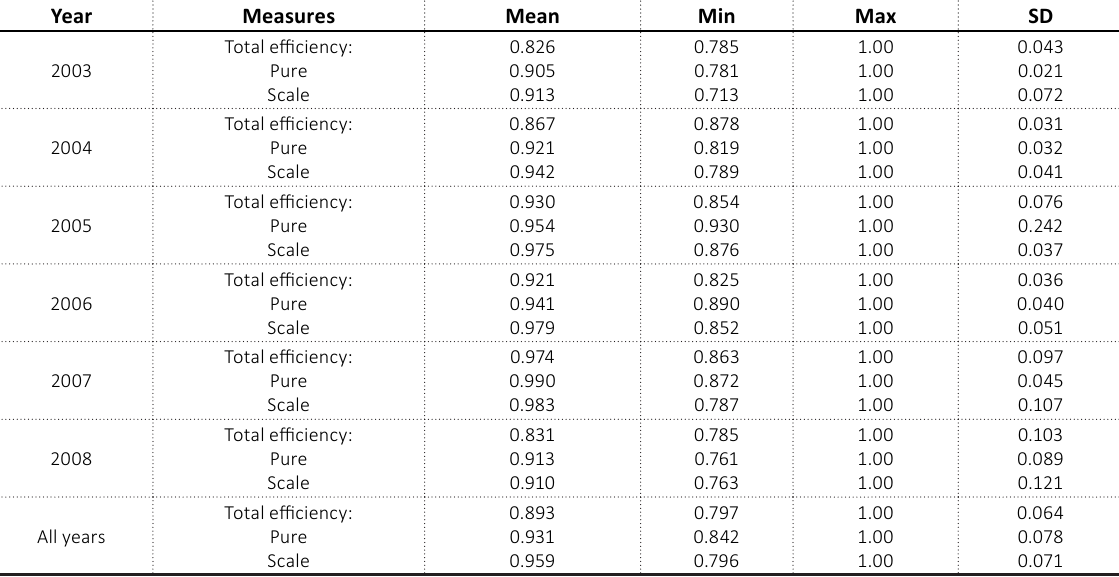
Table 4. Measures of efficiency of conventional commercial banks before the